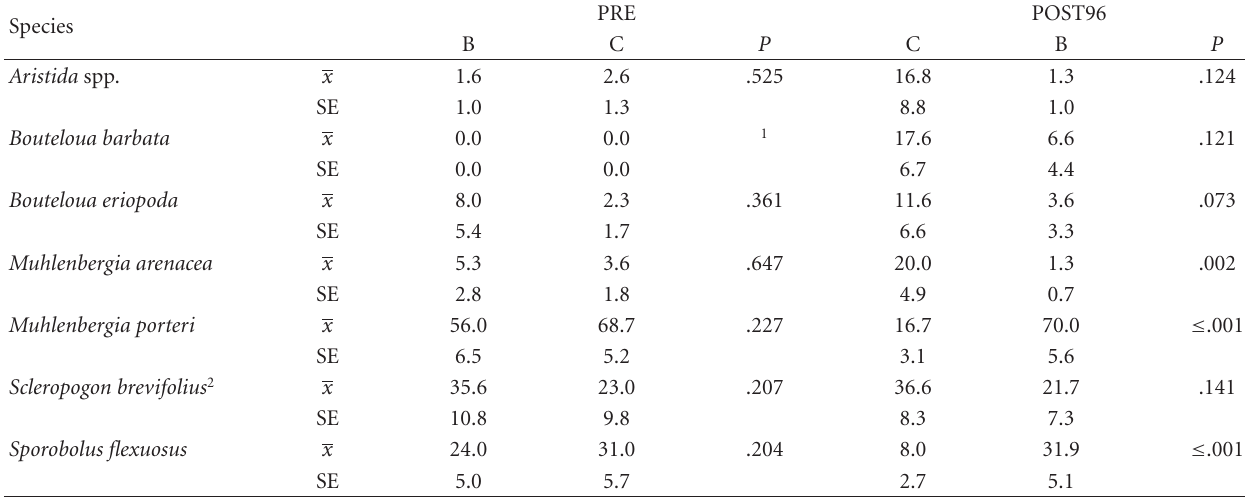
Table 3: Mean frequency (%) of grass species prior to burning, May 1995 (PRE), and one year post burn, July 1996 (POST96), on burned (B) and control (C) sites on Fort Bliss Military Reservation, Otero County, New Mexico. PRE POST96 Species B C P C B P Aristida spp.